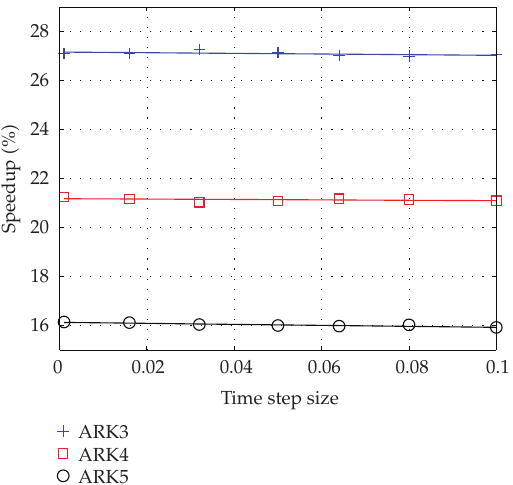
Figure 10: Speedup of ARK methods compared with RK methods for IVP-4.